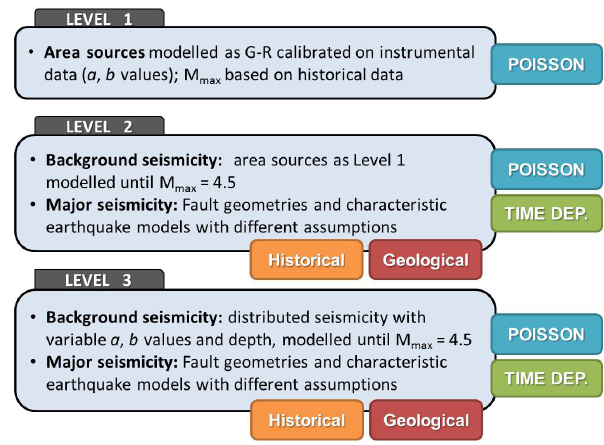
Figure 12. Schematic chart describing the three levels of the source models defined for the Mt. Etna region: increasing complexities are introduced from levels 1 to 3; the final logic tree we adopt is Level 3, with four branching levels. Details of computations are given in Part 2 (Peruzza et al.,